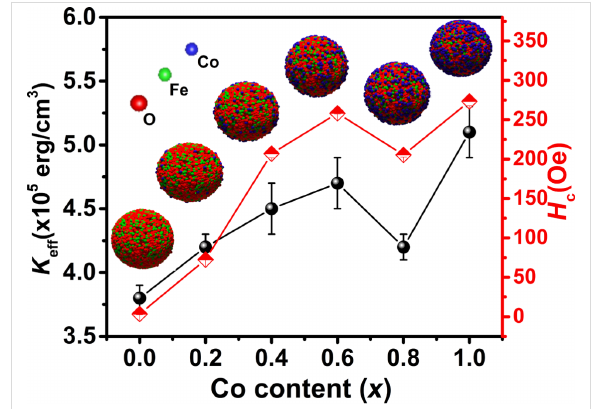
Figure 10: Effective anisotropy constant ( K eff ) and coercivity ( H c ) of the Co x Fe 3 − x O 4